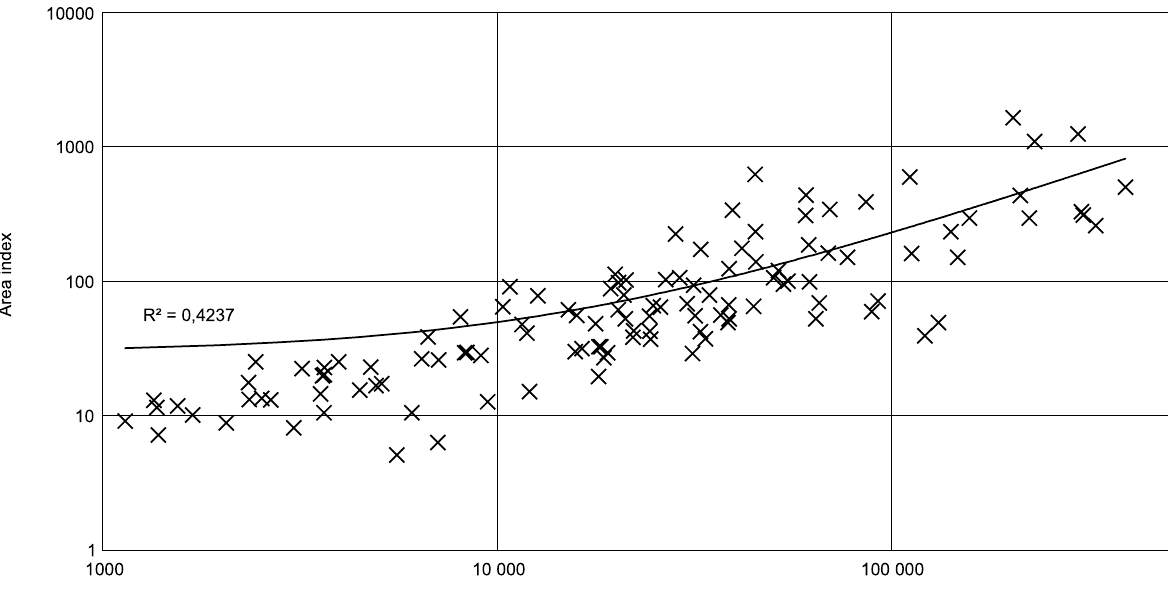
Fig. 6. Distribution of the population index. Fig. 7. Distribution of the area index.